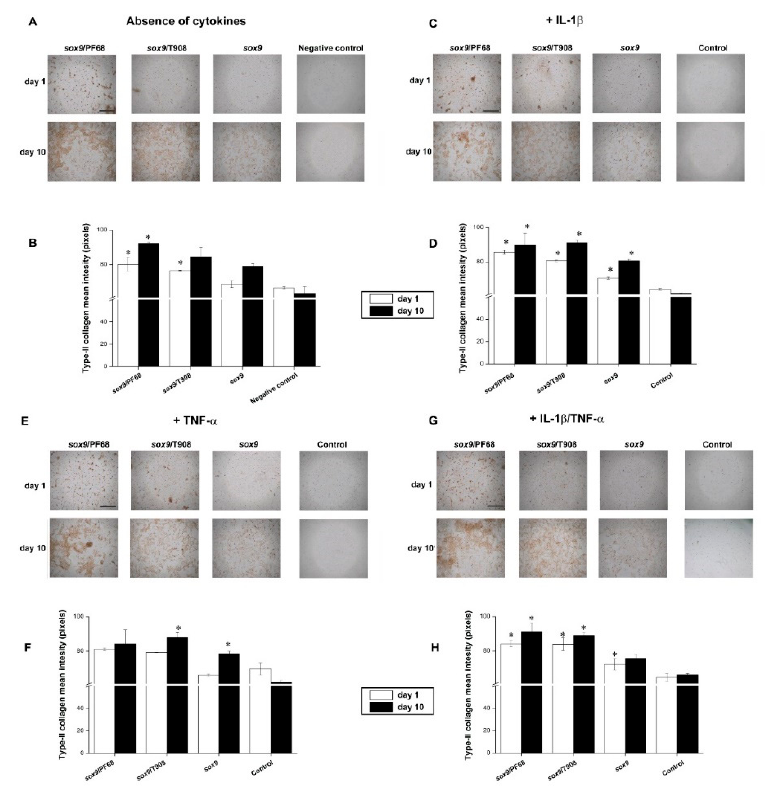
Figure 2. Remodeling activities in rAAV-FLAG-h sox9 -transduced human OA chondrocytes using polymeric micelles. Cells in monolayer culture were directly transduced with the rAAV/polymeric